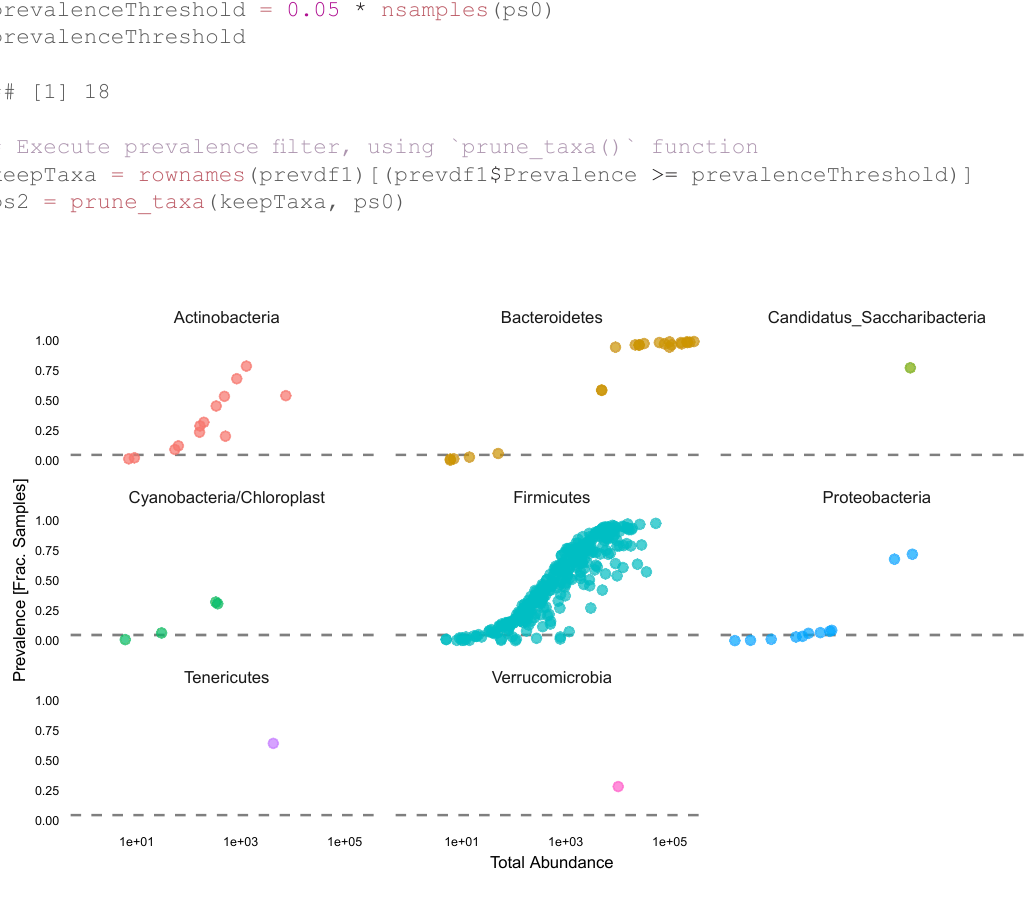
Figure 3. Taxa prevalence versus total counts. Each point is a different taxa. Exploration of the data in this way is often useful for selecting filtering parameters, like the minimum prevalence criteria we will used to filter the data